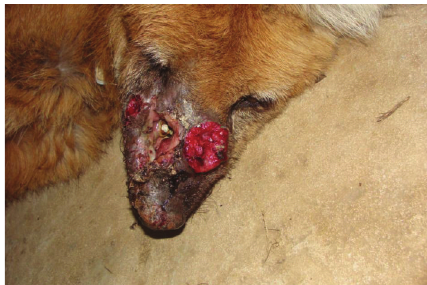
Figure 3: Labial alveolectomy during open extraction of the left maxillary canine